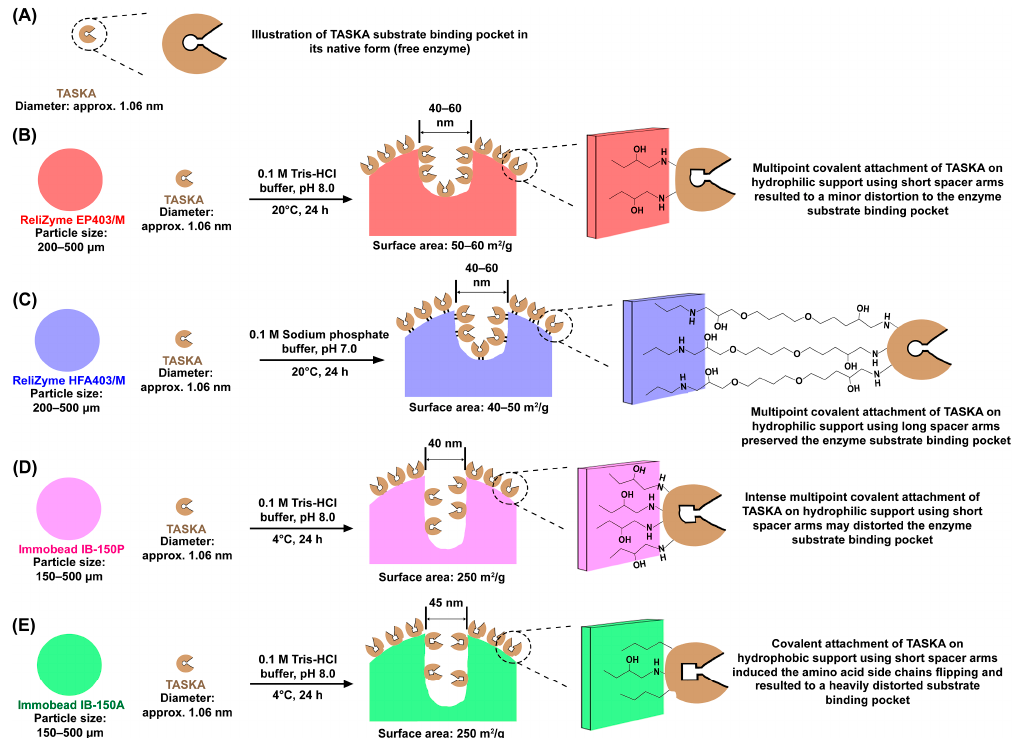
Figure 6. Illustration of ( A ) the substrate-binding pocket of free TASKA and the effect of immobilization on ( B ) ReliZyme EP403/M; ( C ) ReliZyme HFA403/M; ( D ) Immobead IB-150P; and ( E ) Immobead IB-150A towards the immobilized TASKA substrate-binding pocket. The detailed textural properties and functional groups of each support are shown in Table 1. The detailed optimal conditions for TASKA immobilization are shown in Table 2. The diameter of the TASKA enzyme was predicted based on the X-ray crystal structure of the enzyme (PDB ID: 5A2A).